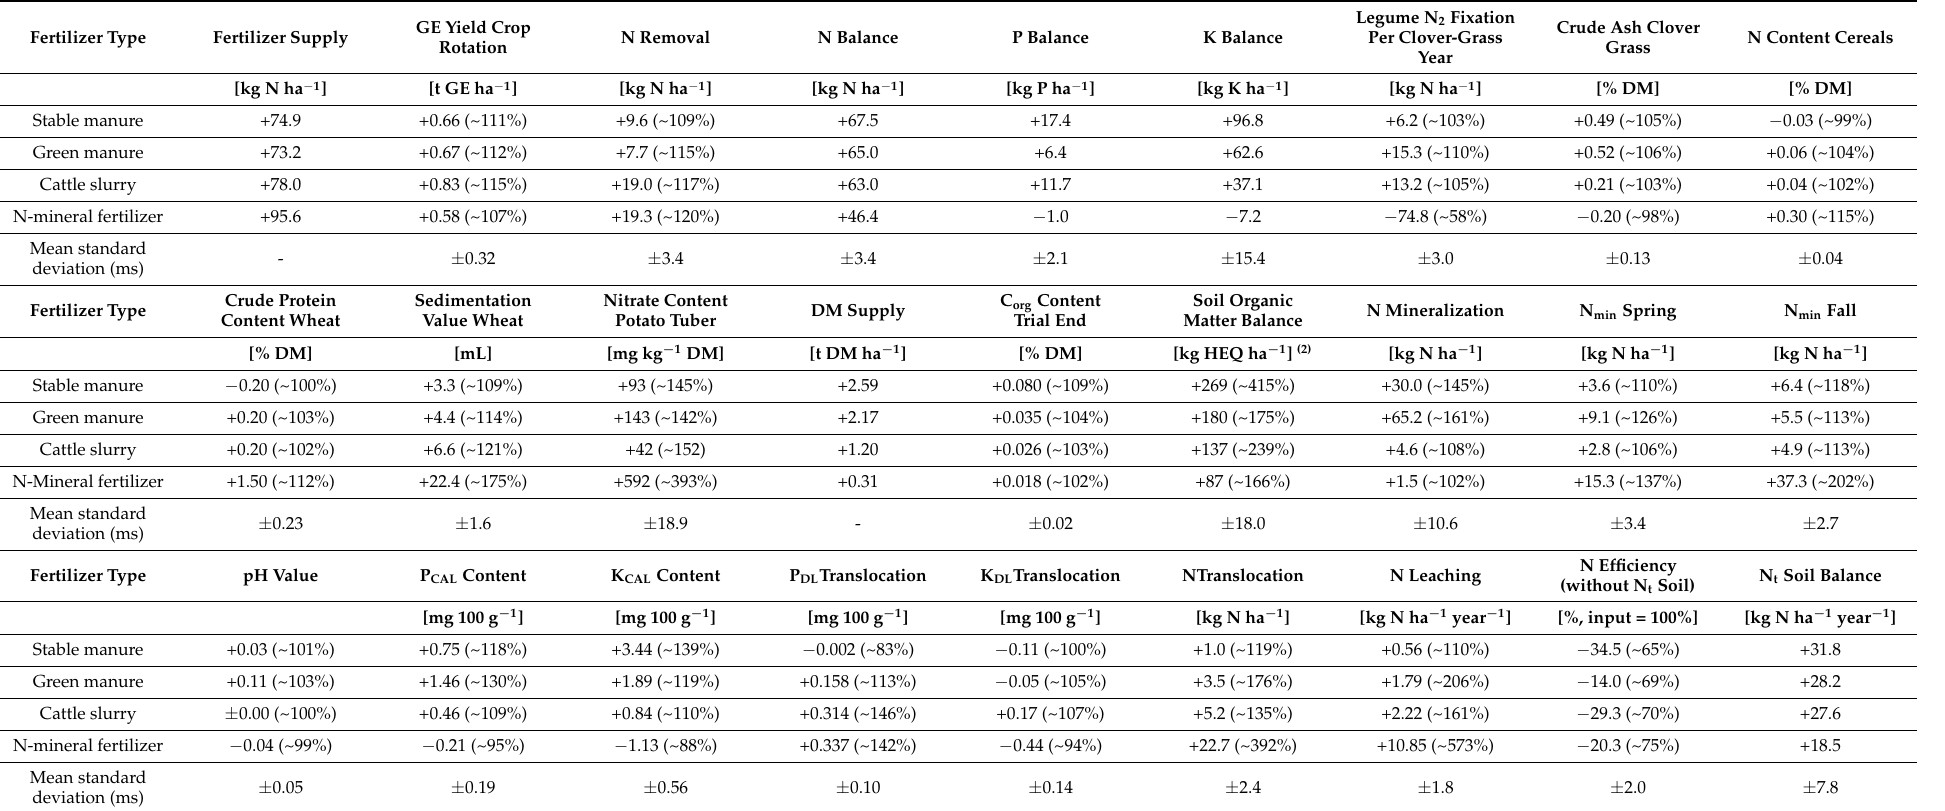
Table 7. Mean differences as well as relative changes compared to no fertilization (standard = 100%) (1) of some characteristics after steady long-term application of stable manure, green manure, slurry, and N-mineral fertilizer in the average of the experimental